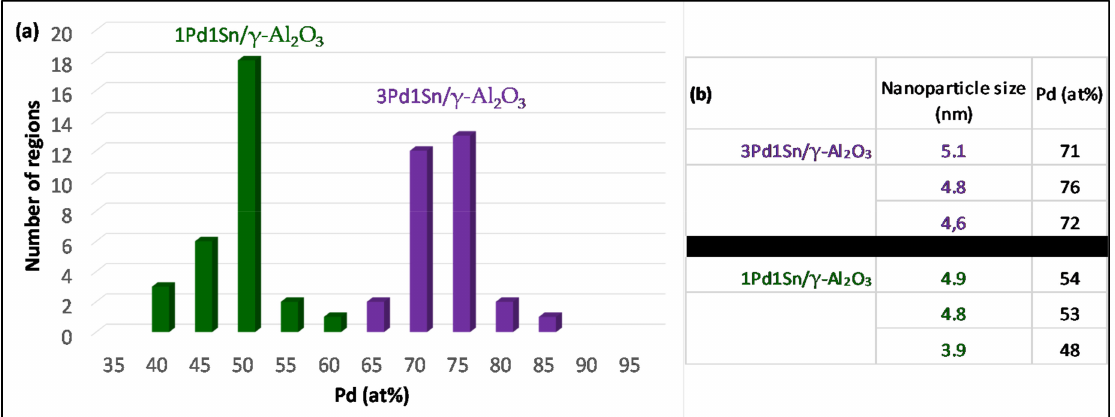
Figure 3. ( a ) Pd content (at%; Sn content is the complement to 100%) measured by EDX (on regions of 5–10 nanoparticles for 3Pd1Sn/ γ -Al 2 O 3 (violet) and 1Pd1Sn/ γ -Al 2 O 3 (green). ( b ) Pd content (at%) measured by EDX on few large (size is given) individual nanoparticles for 3Pd1Sn/ γ -Al 2 O 3 and 1Pd1Sn/ γ -Al 2 O 3